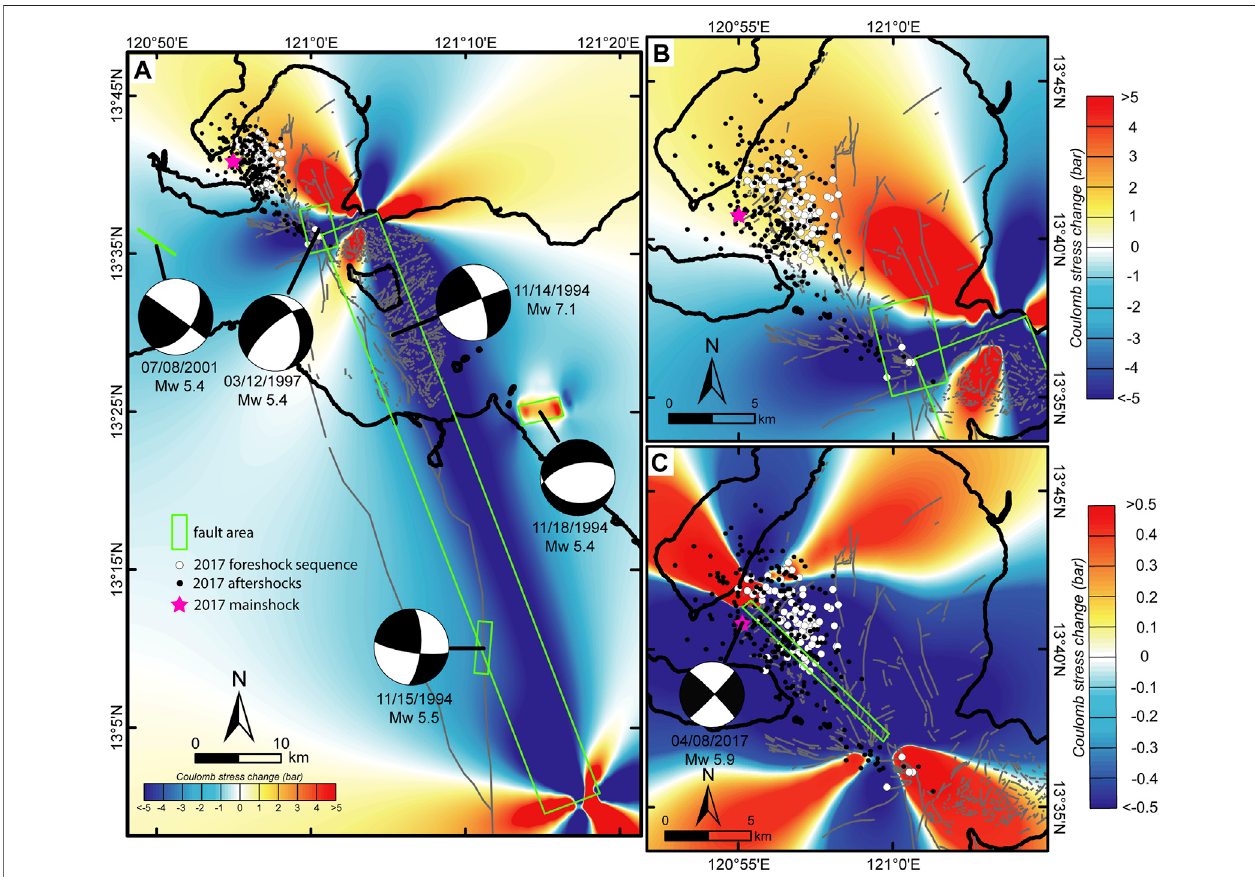
FIGURE 12 | Calculated Coulomb stress change at depth of 14.3 km with (A and B) cumulative 1994 to pre-2017 earthquakes and (B) 2017 Mw 5.9 Batangas BayFaultSystemearthquakeassourcefault.Thereceiverfaultforbothcalculationsisspeci fi edasthesameasthe2017mainshock(strike/dip/rake:314 ° /85 ° /176 ° )at μ ’ = 0.4. The dots represent the relocated events from the 2017 earthquake sequence (Chen et al., 2020).White dots are the foreshock sequence while the black dots are the aftershocks. Dark gray lines are the interpreted faults. Green rectangles depict the source fault area. A purple star indicates the 2017 mainshock location.